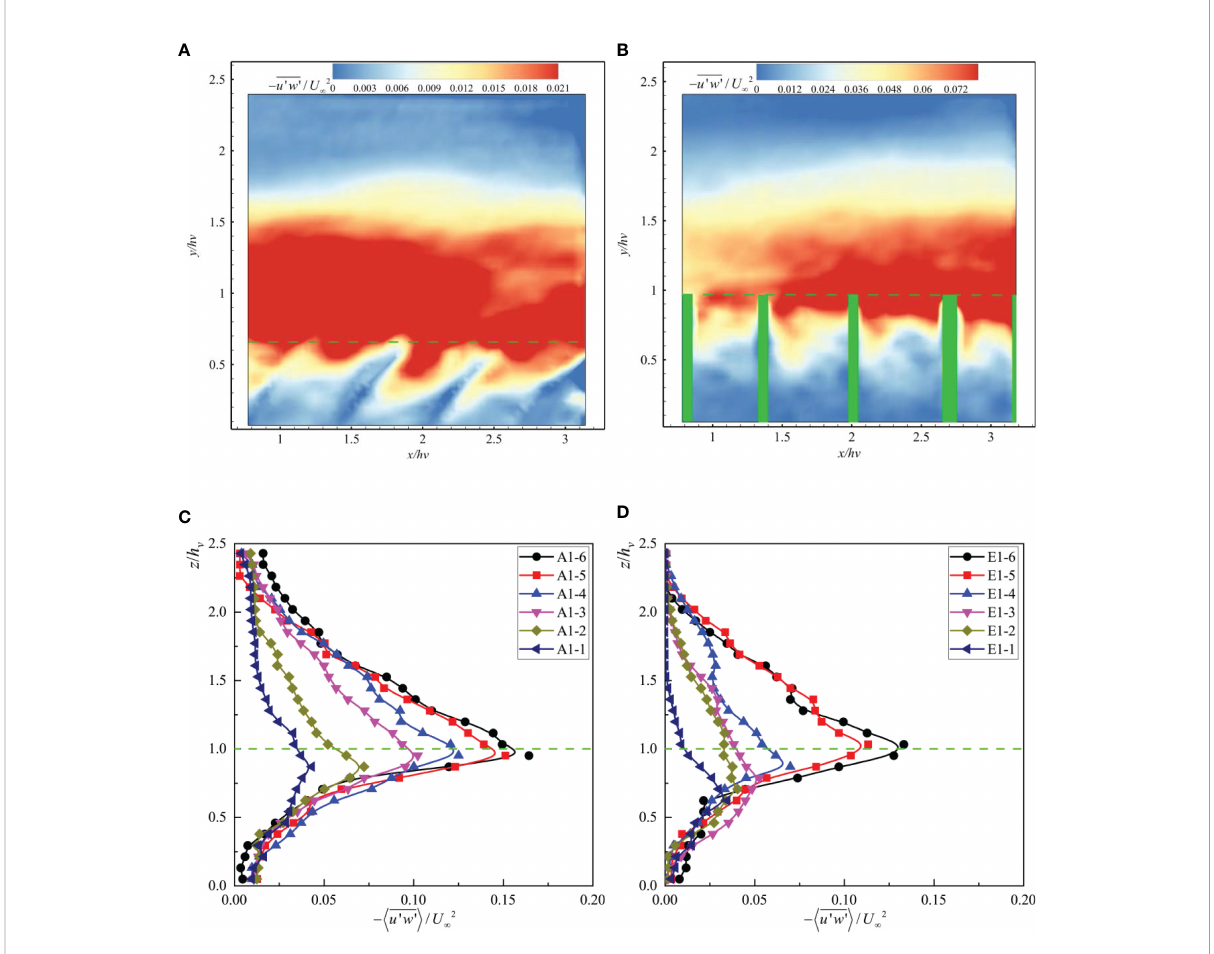
Distribution of the dimensionless time-averaged Reynolds stress − 〈 u 0 w 0 〉 = U 2 ∞ under (A) E1-1 and (B) E1-5 and the distribution of the dimensionless double-averaged Reynolds stress − 〈 u 0 w 0 〉 = U 2 ∞ under (C) Test A and (D) Test